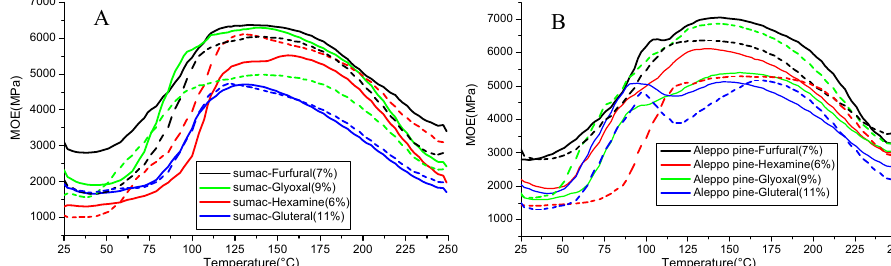
Figure 4. Comparison of thermo-mechanical analysis curing curves of tannins-based resins; continuous line: tannin extract at 70 °C; dashed line: tannin extract at 100 °C. ( A ) Sumac tannins, ( B ) Aleppo tannins.